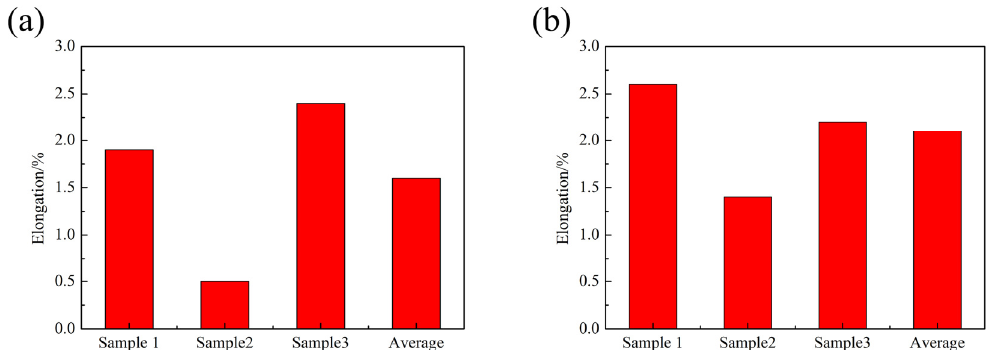
Figure 15. Elongation of the samples in different positions: ( a ) flange; ( b ) bottom.